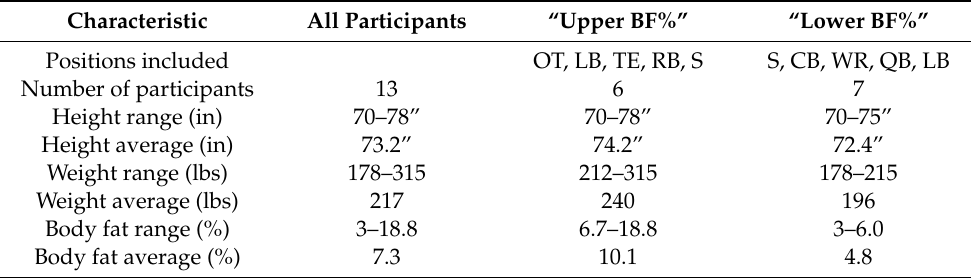
Table 1. Characteristics of